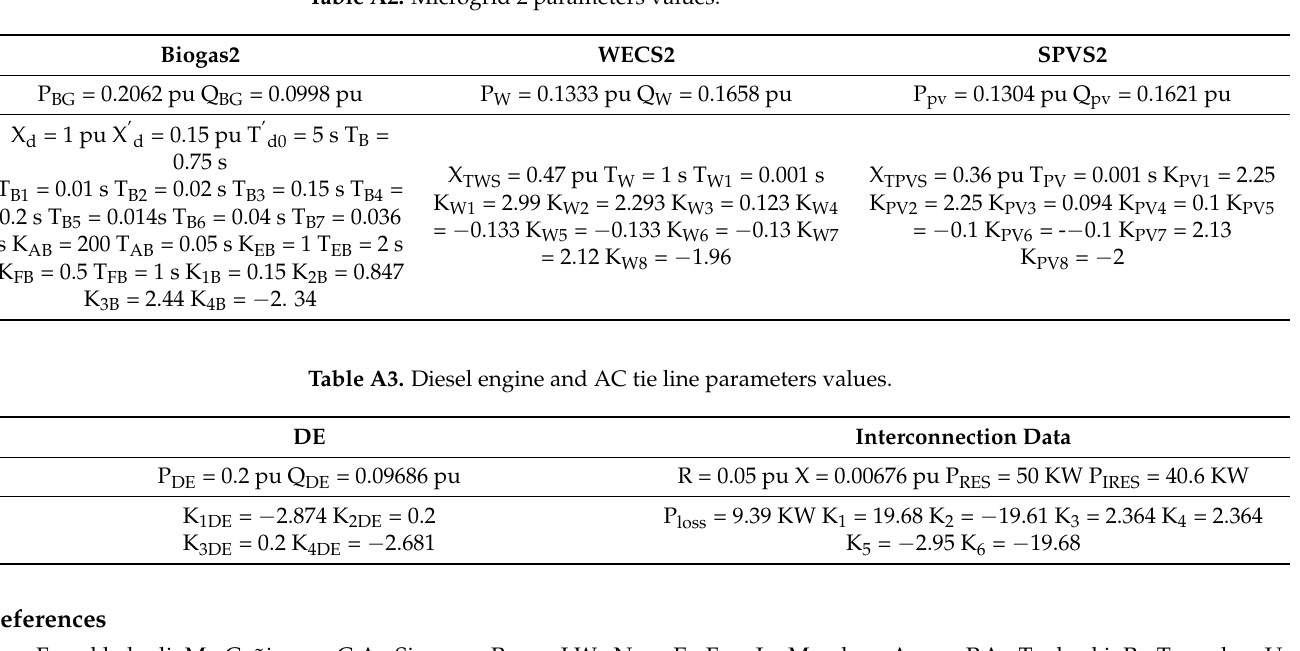
Table A2. Microgrid 2 parameters values.